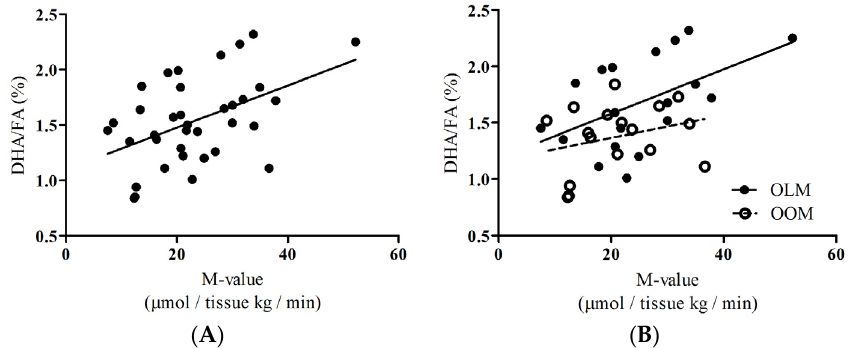
Figure 3. Correlations of DHA/FA ratios (percentages) to whole ‐ body glucose uptake or, metabolizable glucose value derived from hyperinsulinemic ‐ euglycemic clamp technique (M ‐ value) between OOM and OLM groups. ( A ) Whole group. Spearman’s rho value was 0.396 ( p = 0.017), n = 36; ( B ) Spearman’s rho value for OLM group was 0.457 ( p = 0.050) and for OOM group was − 0.124. OLM n = 19; OOM n = 16.